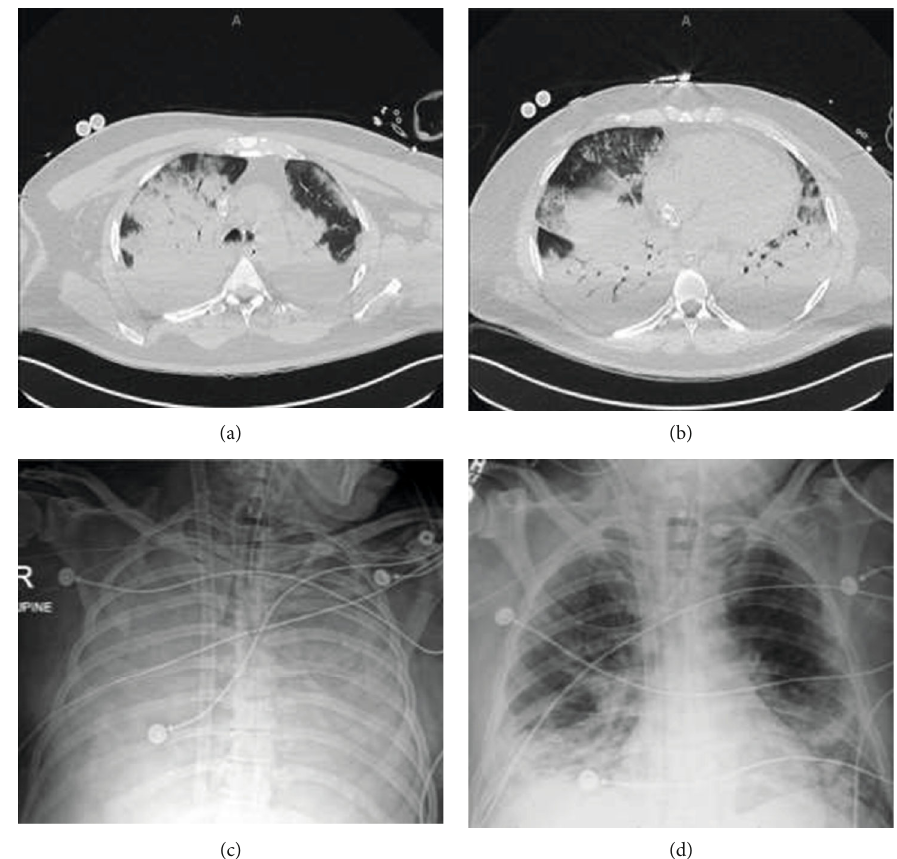
Figure 1: (a, b) Computed tomography of the chest immediately following ECMO cannulation (HD1) demonstrating dense consolidative opacities bilaterally. (c) Chest X-ray from HD8 demonstrating complete opaci fi cation of lungs bilaterally. (d) Chest X-ray from HD12 just prior to ECMO decannulation showing marked improvement aeration of bilateral